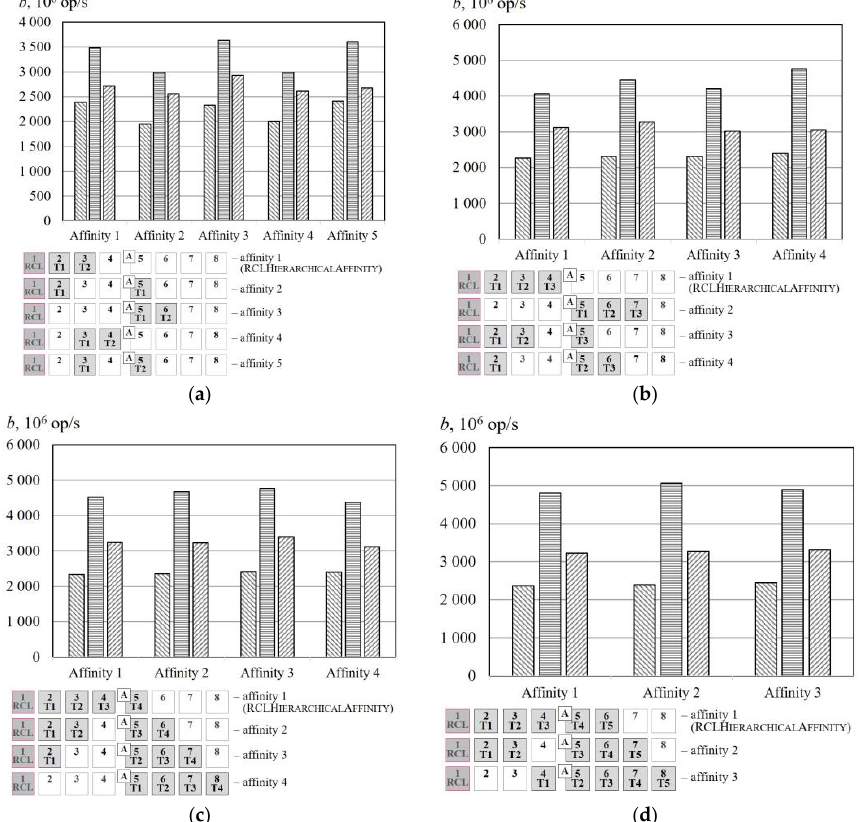
Figure 7. Thread affinity efficiency comparison, Jet cluster (SMP system). ( a ) p = 2; ( b ) p = 3; ( c ) p = 4;